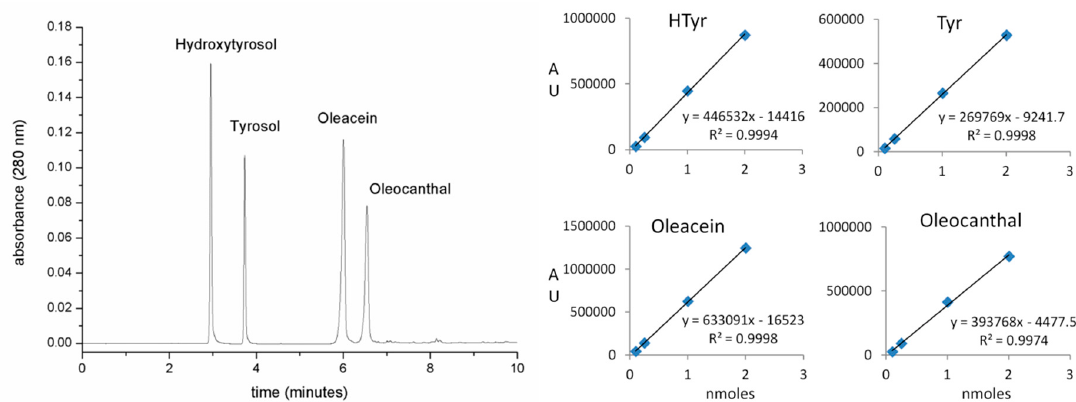
Figure 6. UPLC representative chromatogram ( left ) and calibration curves ( right ) of phenols and secoiridoids analytical standards.